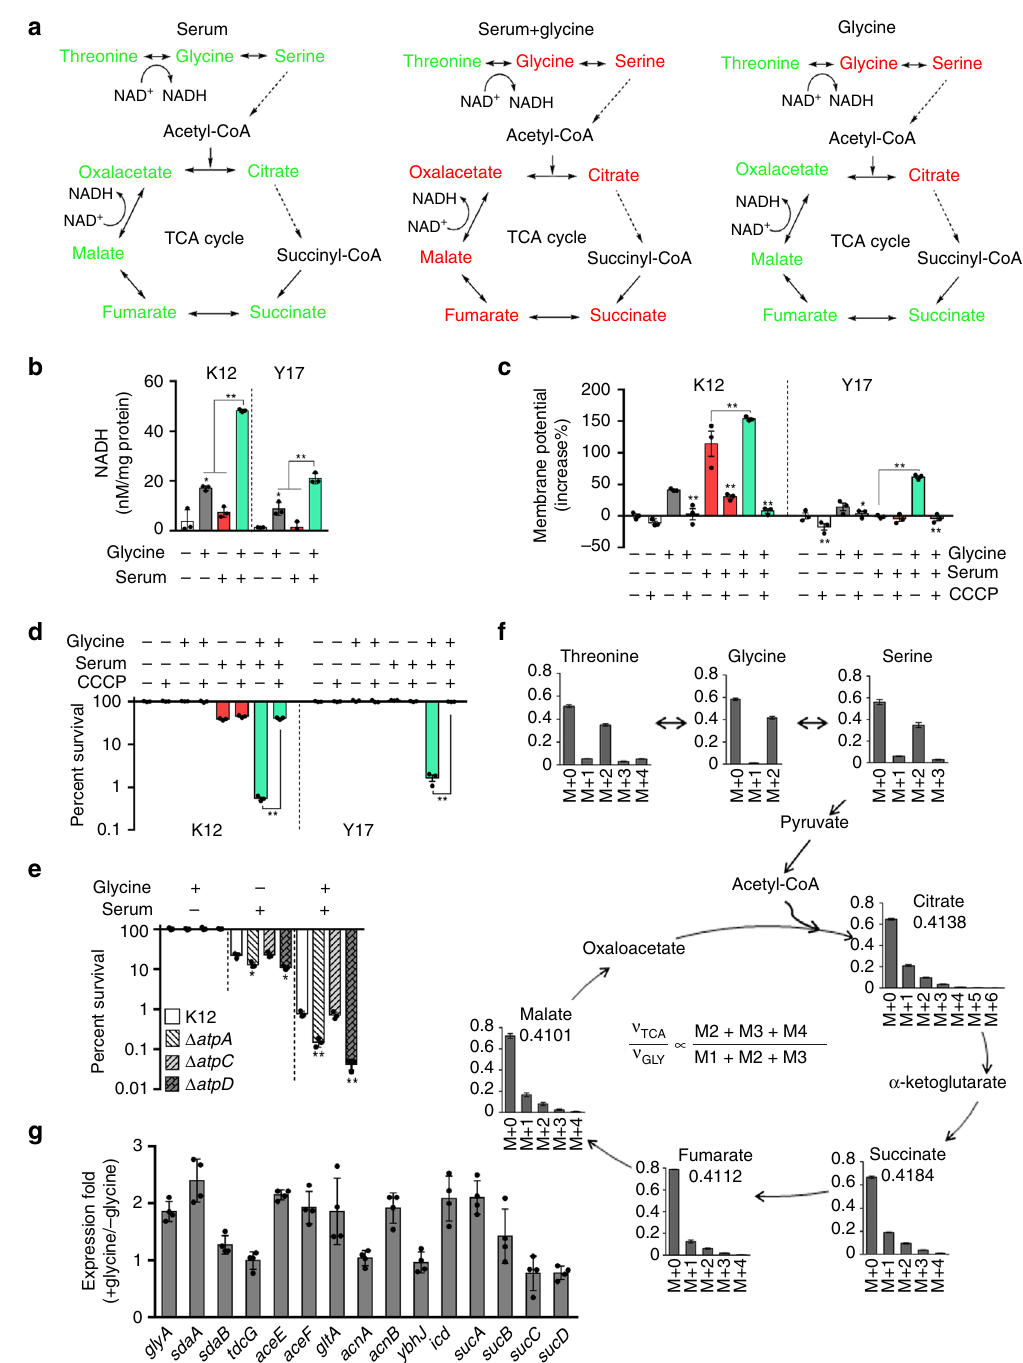
Fig. 3 TCA cycle-triggered membrane depolarization. a Summary of metabolic fl ux through the TCA cycle in the presence of serum, serum plus glycine, or glycine. Change in metabolite abundance is indicated as follows: red, upregulation; green, down-regulation; gray, not detected. NAD + , nicotinamide adenine dinucleotide; NADH, reduced nicotinamide adenine dinucleotide ( n = 6). b NADH concentration in E. coli K12 and Y17 in the presence of 100 μ L serum, 100 mM glycine or both for 2 h ( n = 3). c , d Membrane potential ( c ) and percent survival ( d ) of E. coli K12 and Y17 treated with 100 µ L serum for 2 h in presence or absence of 100 mM glycine or/and CCCP ( n = 3). For membrane potential, 50,000 cells were recorded with forwarding versus side scatter and were gated before data acquisition. e Percent survival of E. coli , Δ atpA , Δ atpC , and Δ atpD in the presence of 100 mM glycine, 100 µ L serum, or both for 2 h ( n = 3). f Mass isotopomer distributions for 13 C labeled glycine detected in a nontargeted manner in the presence of 100 mM glycine. The relative fl ux for that metabolite in the TCA cycle ( υ TCA / υ GLY ) is de fi ned (M2 + M3 + M4)/(M1 + M2 + M3) ratio, where υ TCA refers to the turnover of a particular metabolite pool and υ GLY refers to the fl ux of glycine carbon atoms to the TCA cycle. g qRT-PCR for relative expression of genes contributed to the fl ux from serine to the upper TCA cycle in the presence or absence of 100 mM glycine ( n = 3). Results are displayed as mean ± SEM ( b – g ), and signi fi cant differences are identi fi ed (* p < 0.05, ** p < 0.01) as determined by two-tailed Student ’ s t test ( a – e , g